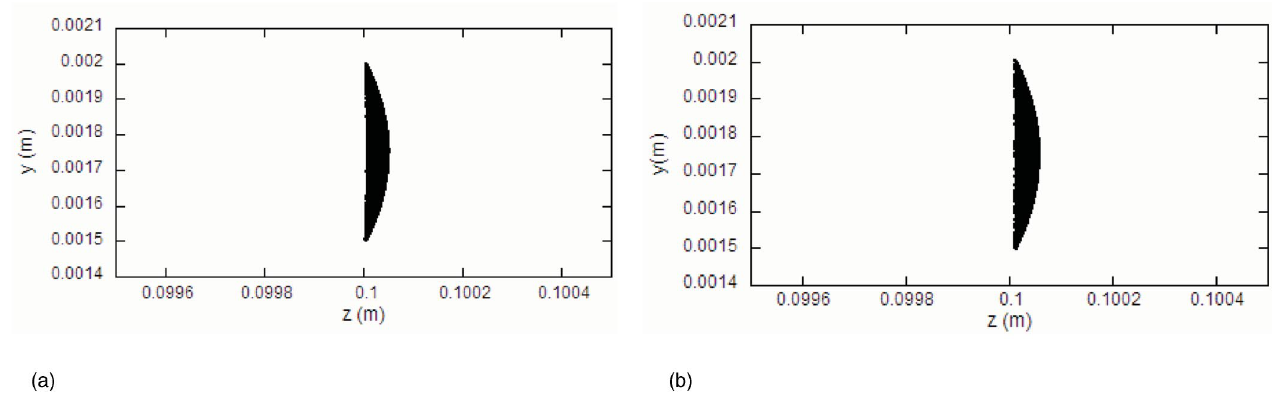
FIG. 6. Particle axial positions for an initially vertical slice of the beam, showing very small relative axial motion (a) for the wiggler field configuration, and (b) for the PPM field configuration.